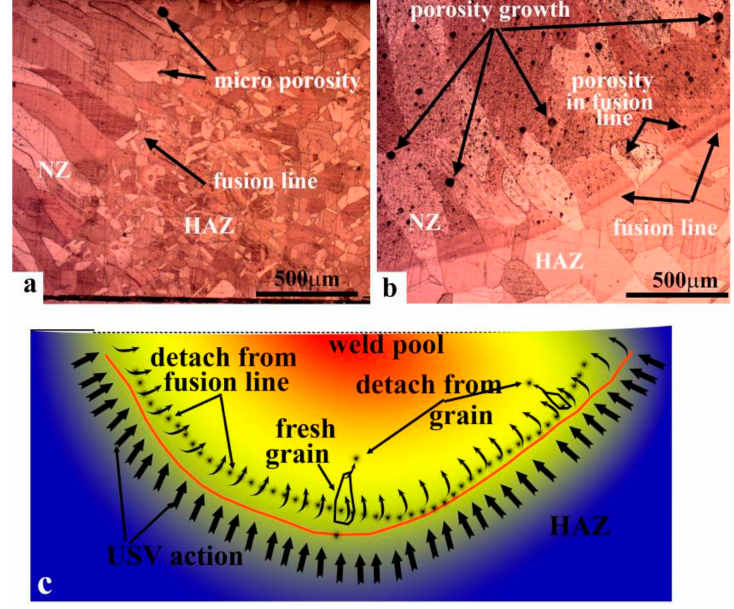
Figure 13. The microstructure around the fusion line for a GTA spot-welded joint ( a ) with USV; ( b ) without USV; and ( c ) the mechanism of the fusion line dissolving and grain